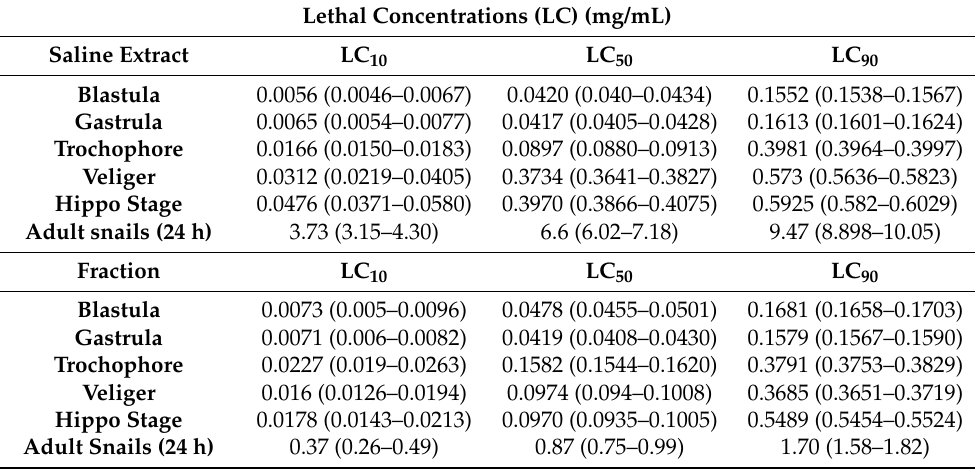
Table 2. Lethal concentrations of the different embryonic stages of B. glabrata after exposure to saline extract and fraction of B. monandra